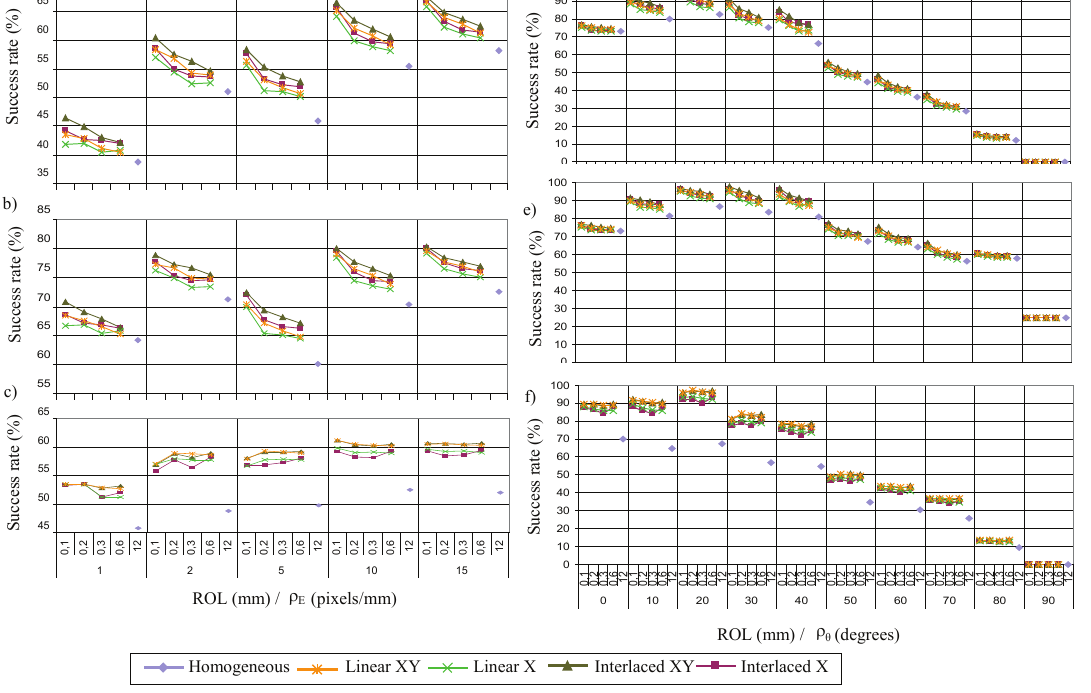
Figure 14. Success rates for inspecting a crater ( a , d ), crack ( b , e ) and chromatic defect ( c , f ) according to size of lighting regions and scale ( a – c ) and angle of perception ( d – f